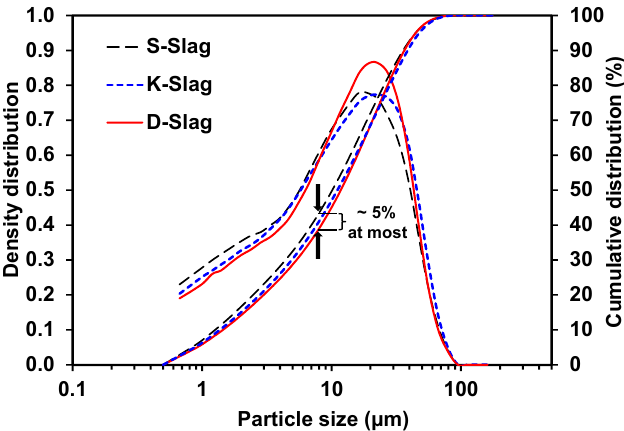
Figure 2. Particle ‐ size distribution of raw GGBFS. Figure 2. Particle-size distribution of raw